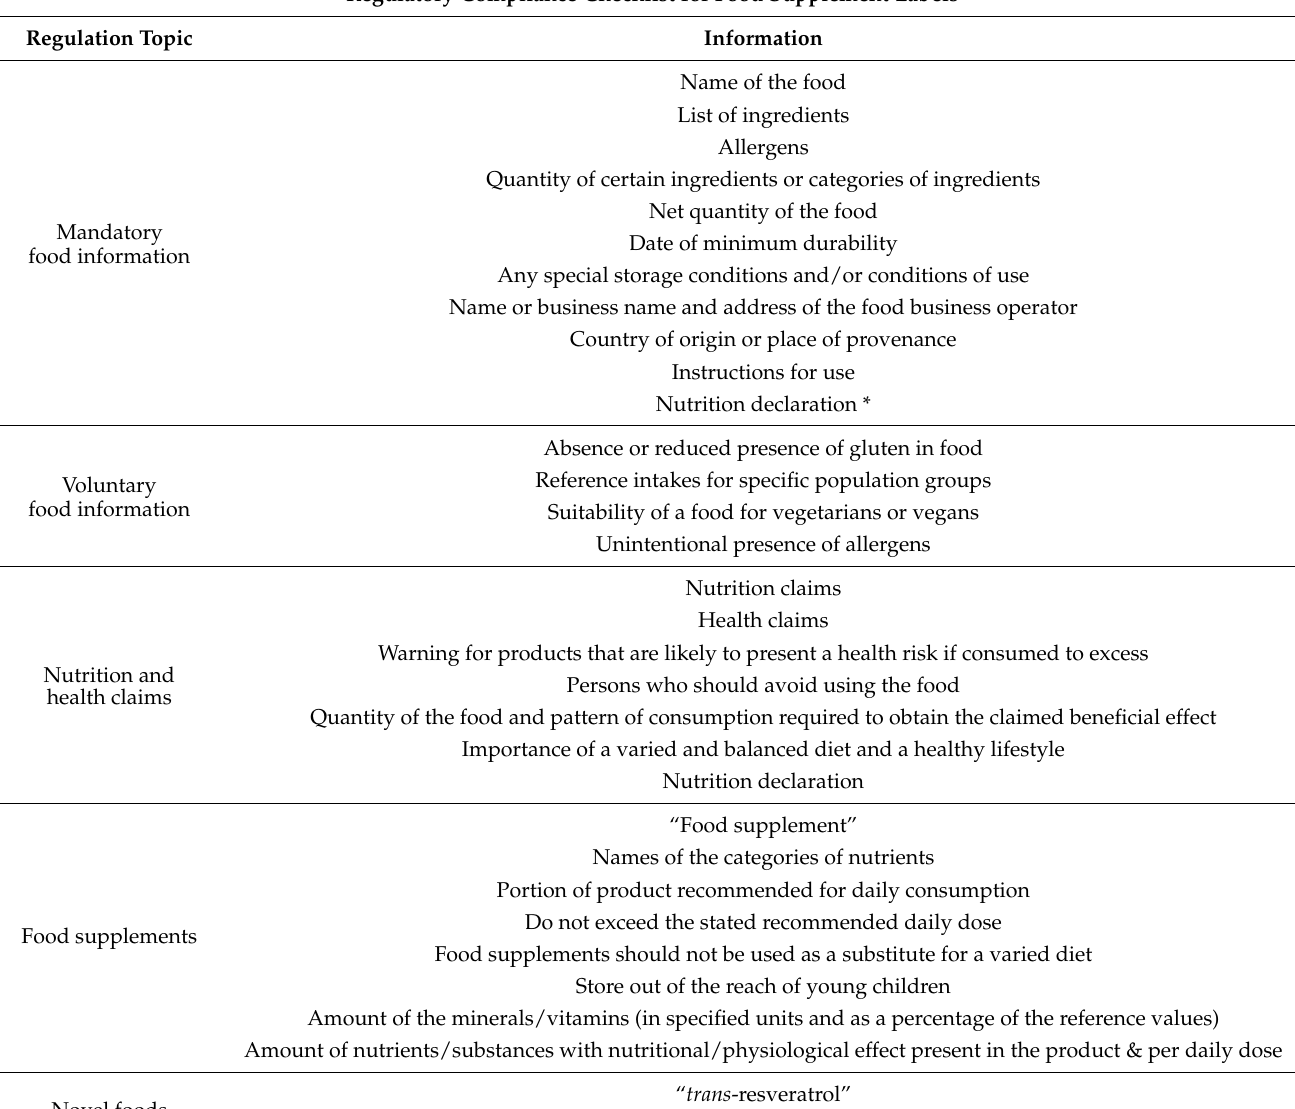
Table 1. Regulatory compliance checklist for food supplement labels for the regulation topics of food labeling, health and nutrition claims, food supplements and novel